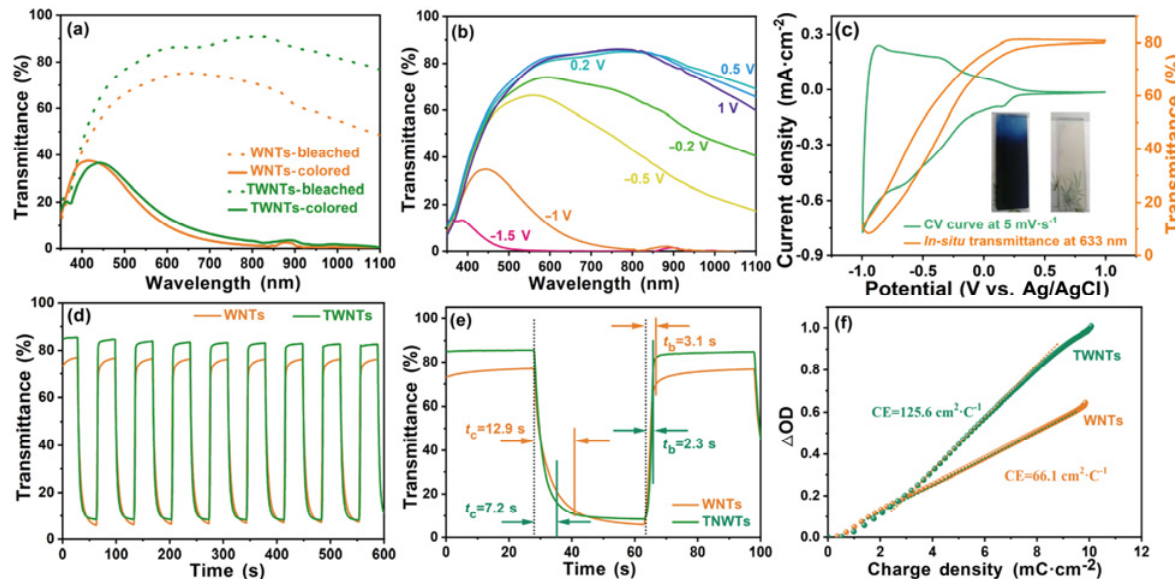
Fig. 3 EC performance of WNTs and TWNTs films. Transmittance spectra of WNTs and TWNTs films under the bleached and colored states in the wavelength range of 350–1100 nm (a). Transmittance spectra of TWNTs film under various potentials (b), CV curve and the corresponding in-situ transmittance at 633 nm at a scan rate of 5 mV·s − 1 in the potential range of ±1 V (c), in-situ transmittance spectra at 633 nm under an alternating potential of ±1 V for 35 s each (d), a zoom-in view on one reversible cycle between colored and bleached states and the corresponding switching time (e), and CE curves